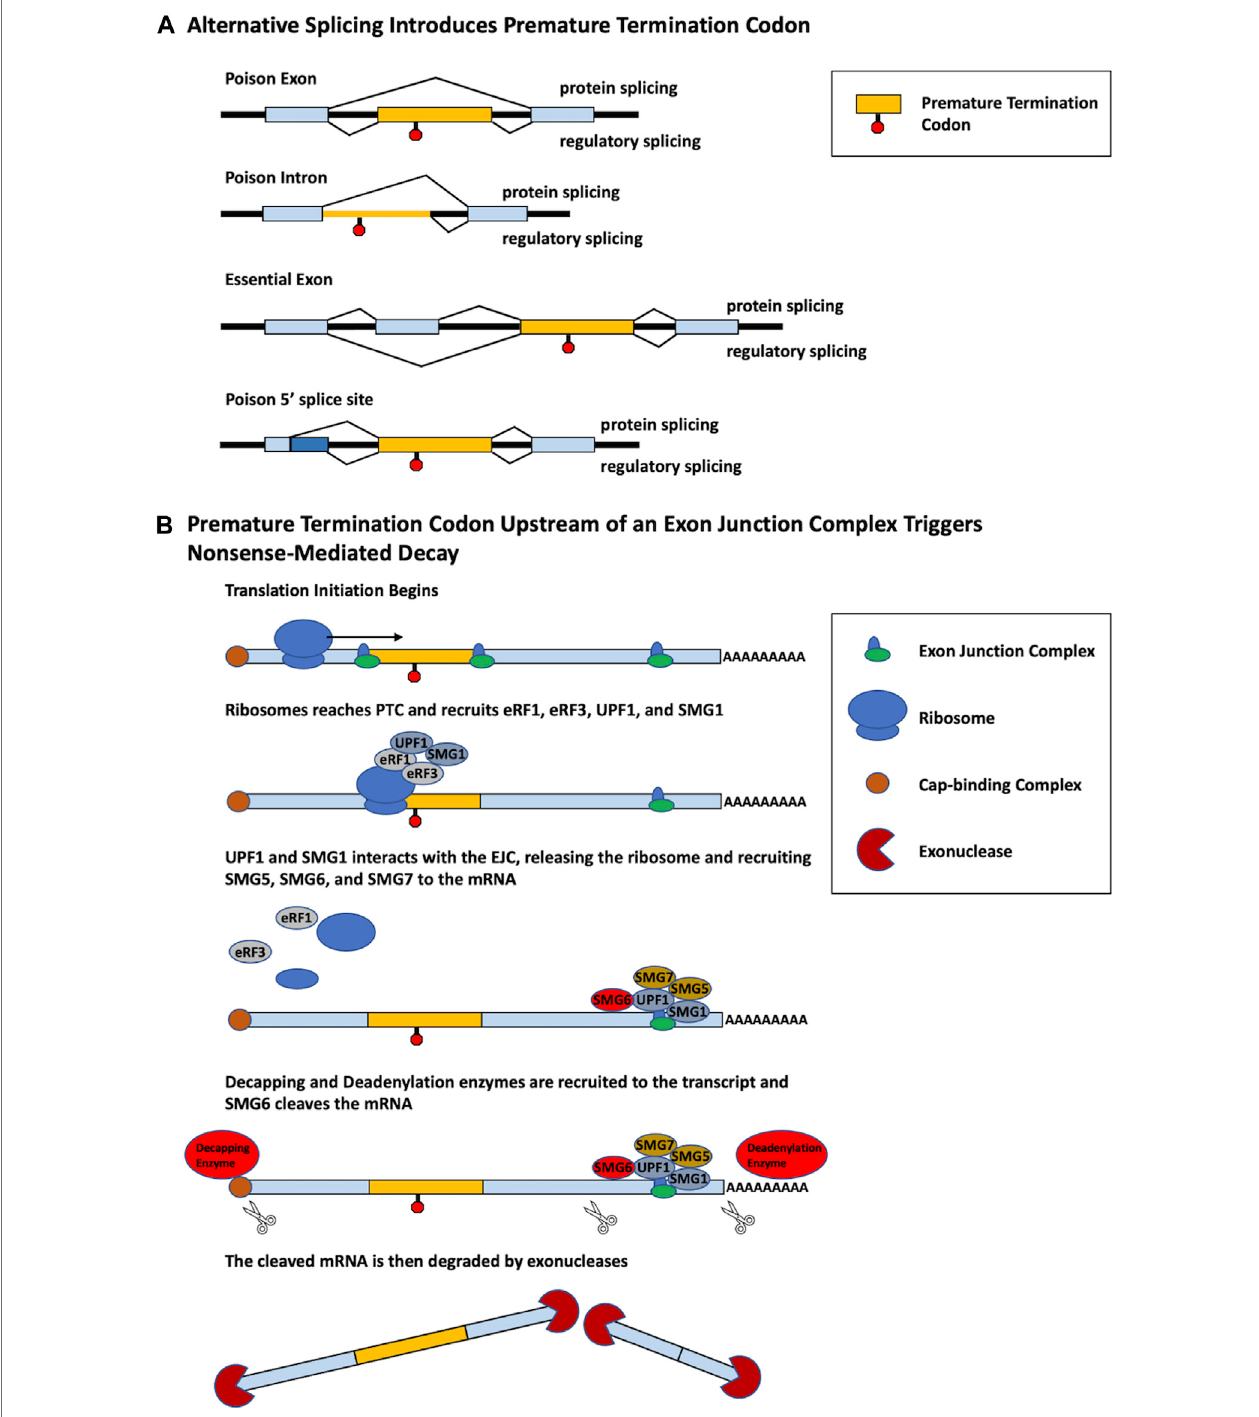
FIGURE 1 | Different alternative splicing patterns can induce PTC inclusion that triggers NMD. (A) Multiple different alternative splicing events produce PTC- containing transcripts. Poison exons are cassette exons that contain an in-frame PTC and induce NMD when spliced into a transcript. The retention of a poison intron containing a PTC induces NMD. Essential exons induce NMD when skipped. An alternative poison 5 ′ splice site induces a frame shift that generates a PTC. For each model, splicing that generates a protein is shown on top, whereas regulatory splicing that results in AS-NMD is shown below. (B) PTC-containing mRNA is degraded by the process of NMD. Translation initiation begins to produce a polypeptide from the mRNA. Upon reaching the PTC, the proteins eRF1, eRF3, UPF1, and SMG1 are recruited to the ribosome. Recognition and interaction with a downstream EJC by UPF1 and SMG1 triggers the release of the ribosome and recruitment of SMG5, SMG6, and SMG7. Decapping and deadenylation enzymes are then recruited to the mRNA cleaving the 5 ′ cap and polyA tail, furthermore SMG6 cleaves the mRNA in two. The PTC-containing mRNA, no longer being protected, is then degraded by exonucleases.